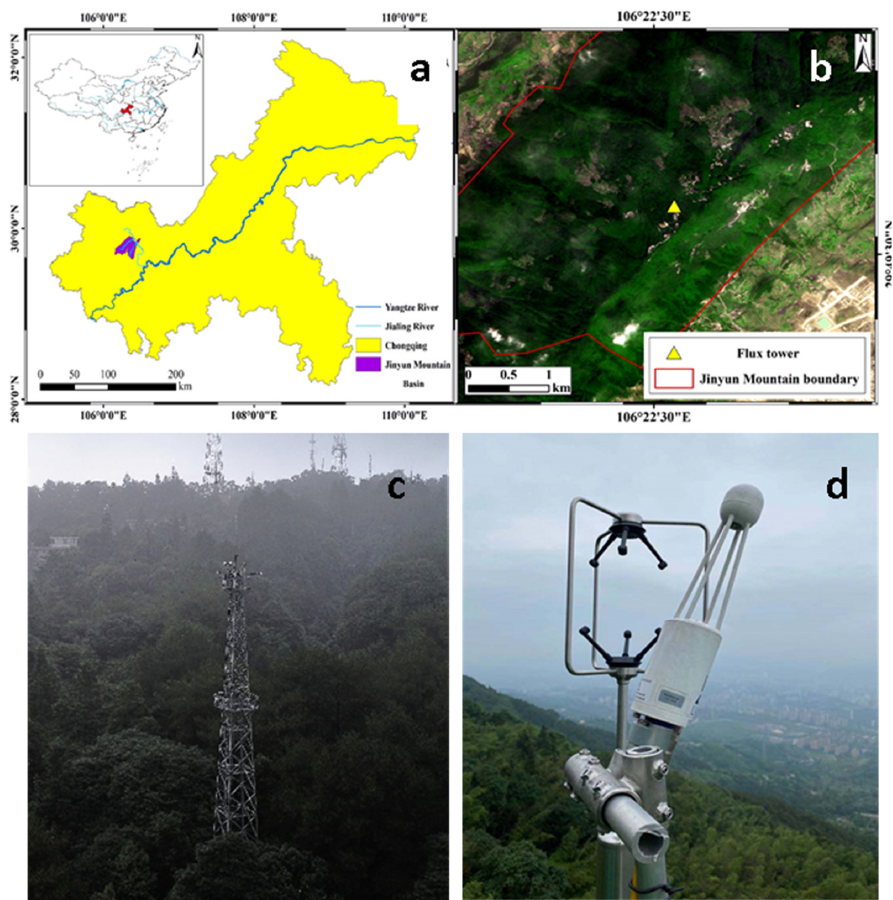
Figure 1. Location of study site. ( a ): Location of Chongqing and Jinyun Mountain Basin; ( b ): Location of flux tower in Jinyun Mountain reserve; ( c ): Photos of flux tower taken by UAV; ( d ): Flux measuring